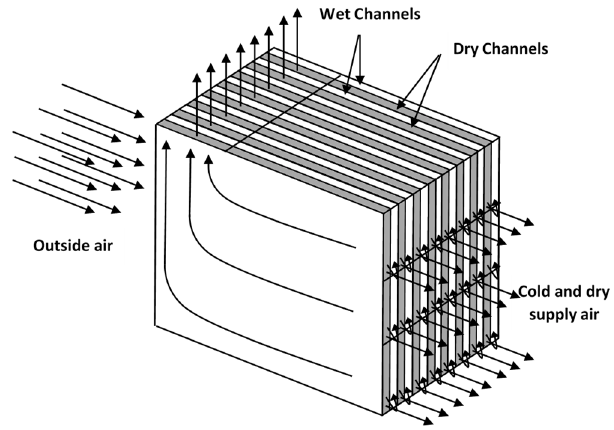
Figure 3. Dew point cooler pads and air flow.